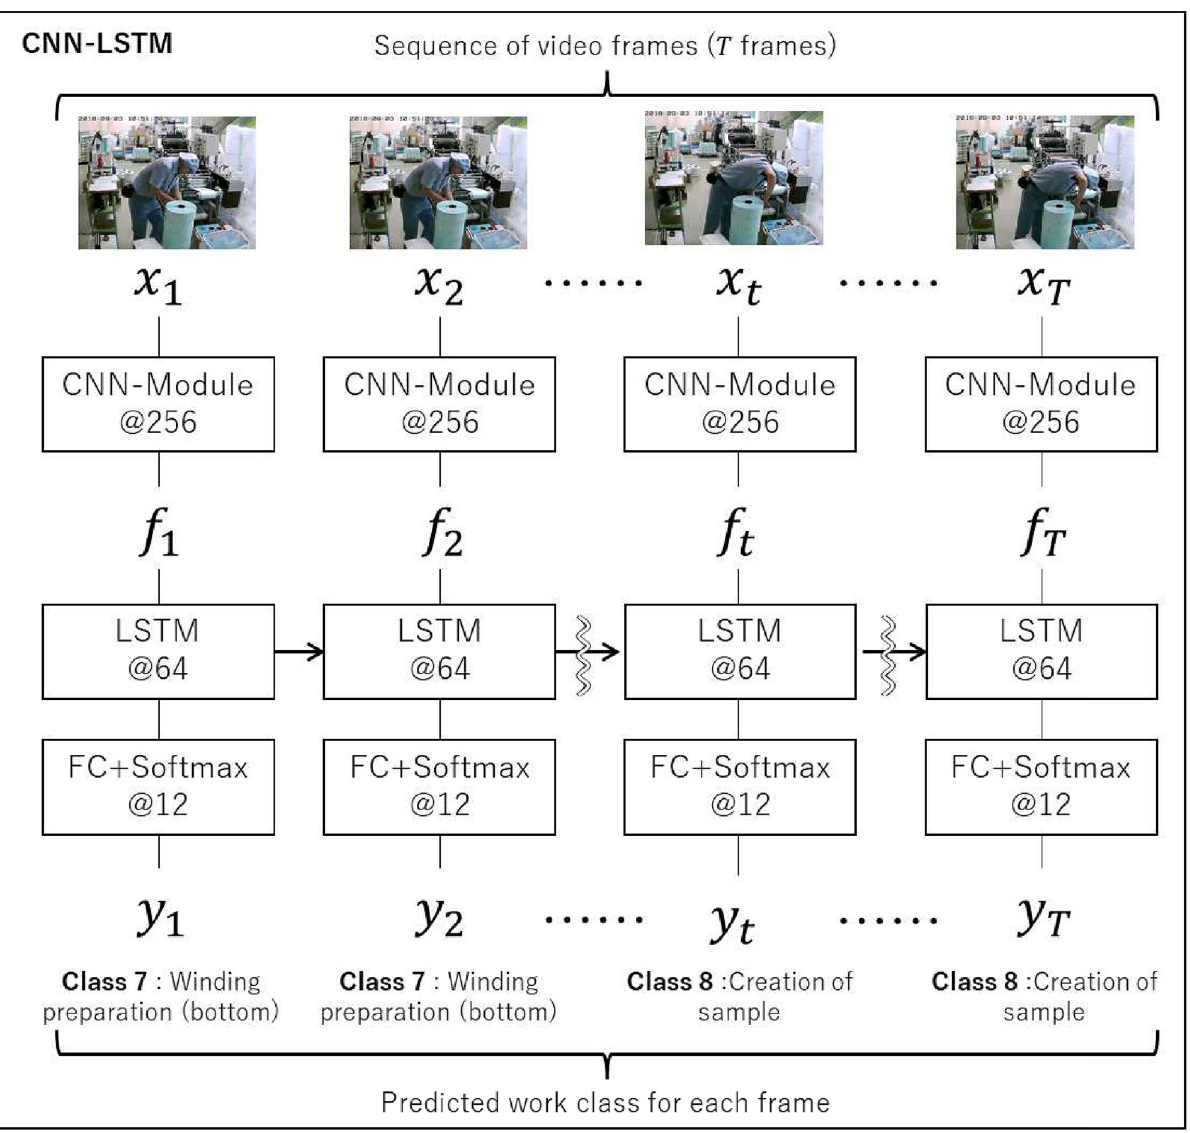
Fig 2. CNN-LSTM model architecture (baseline and ours). All CNN-Modules and FCs share weights with each other. The number marked @ is the output channel. Each layer component corresponds to the class diagram in Fig 3. Hyper-parameters not listed use the default values from Fig 3. CNN-Module: It is described later in Fig